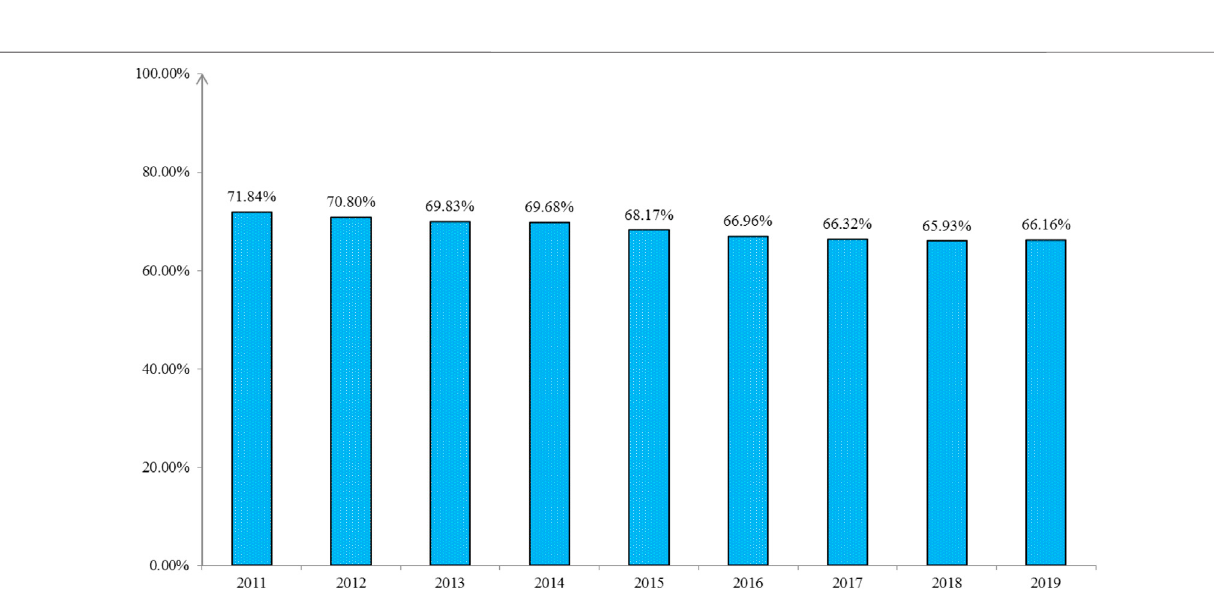
FIGURE7| Percentage ofenergy consumption inindustry ontotalenergy consumptioninChinaduring2011 – 2019.Source:Theauthor searchedthetotalenergy consumption and energy consumption in industry from Total Energy Consumption by Sector in the China Energy Statistical Yearbook 2020 and calculated these